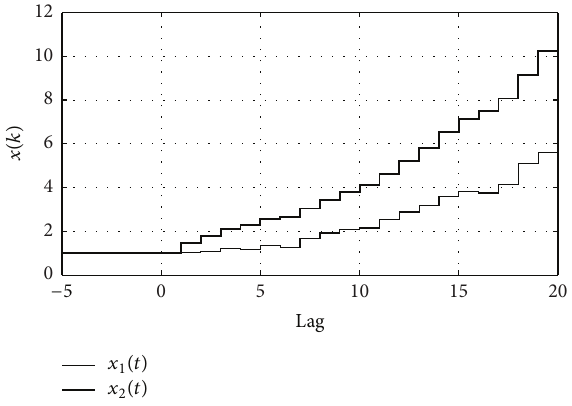
Figure 6: Initial state response of system (65) with time-varying delay 1 ≤ 𝑑(𝑘) ≤ 5 .